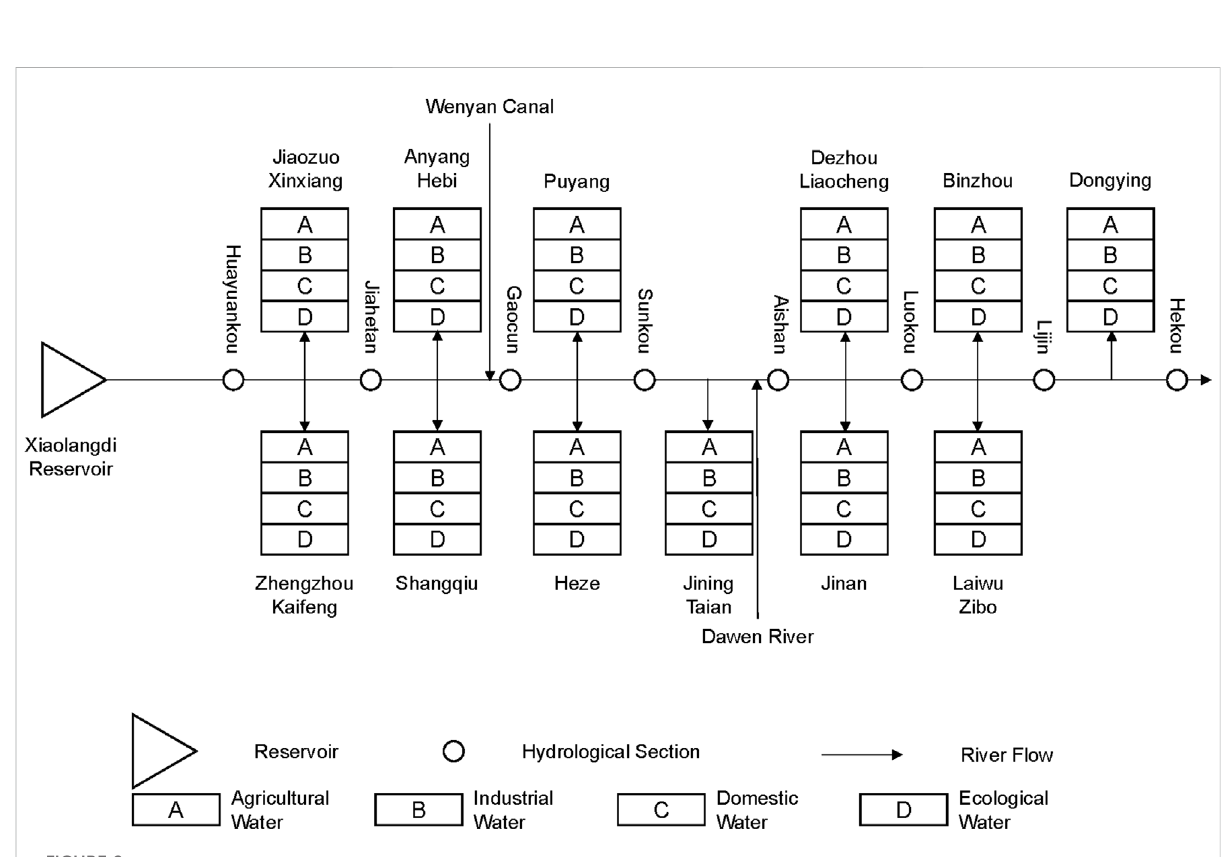
FIGURE 2 Generalized diagram of water resource users in the lower Yellow